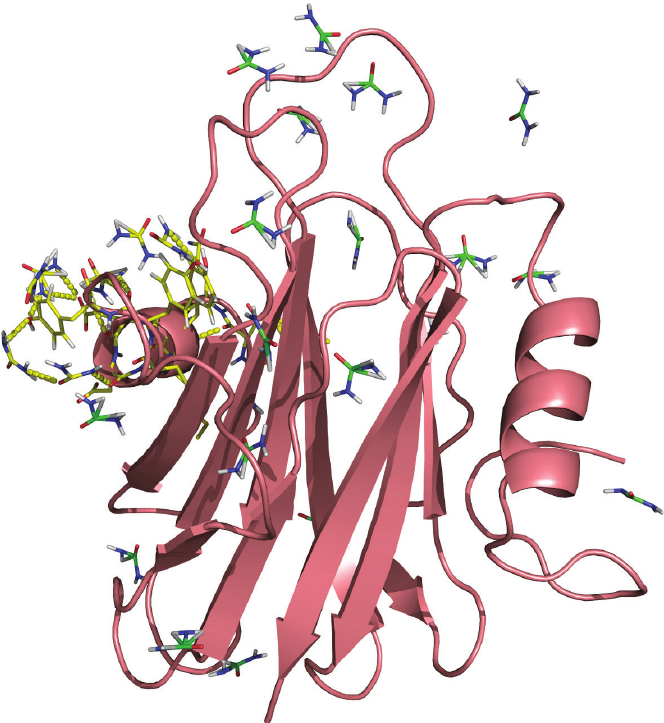
Figure 8 - Illustration of the of hydrogen bond interactions between hydrophilic residues in the C-terminal α-helix of StnII (i.e. Tyr135 and Tyr136) and urea molecules that accumulates around